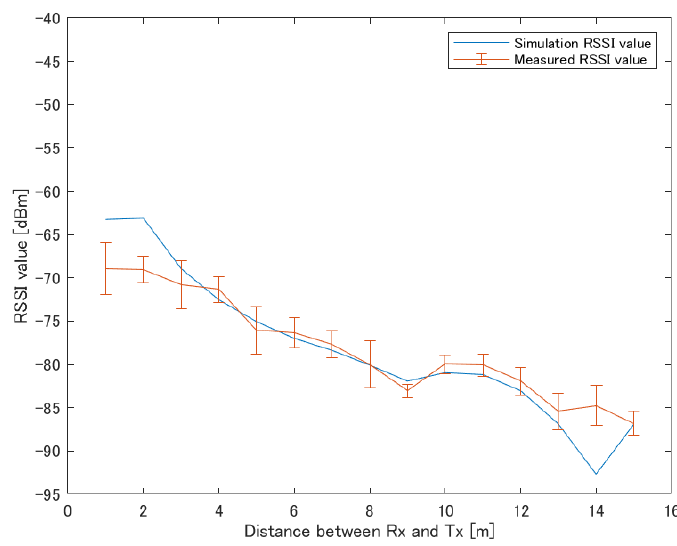
Figure 12. Appearance of RSSI measurement in the wilderness.